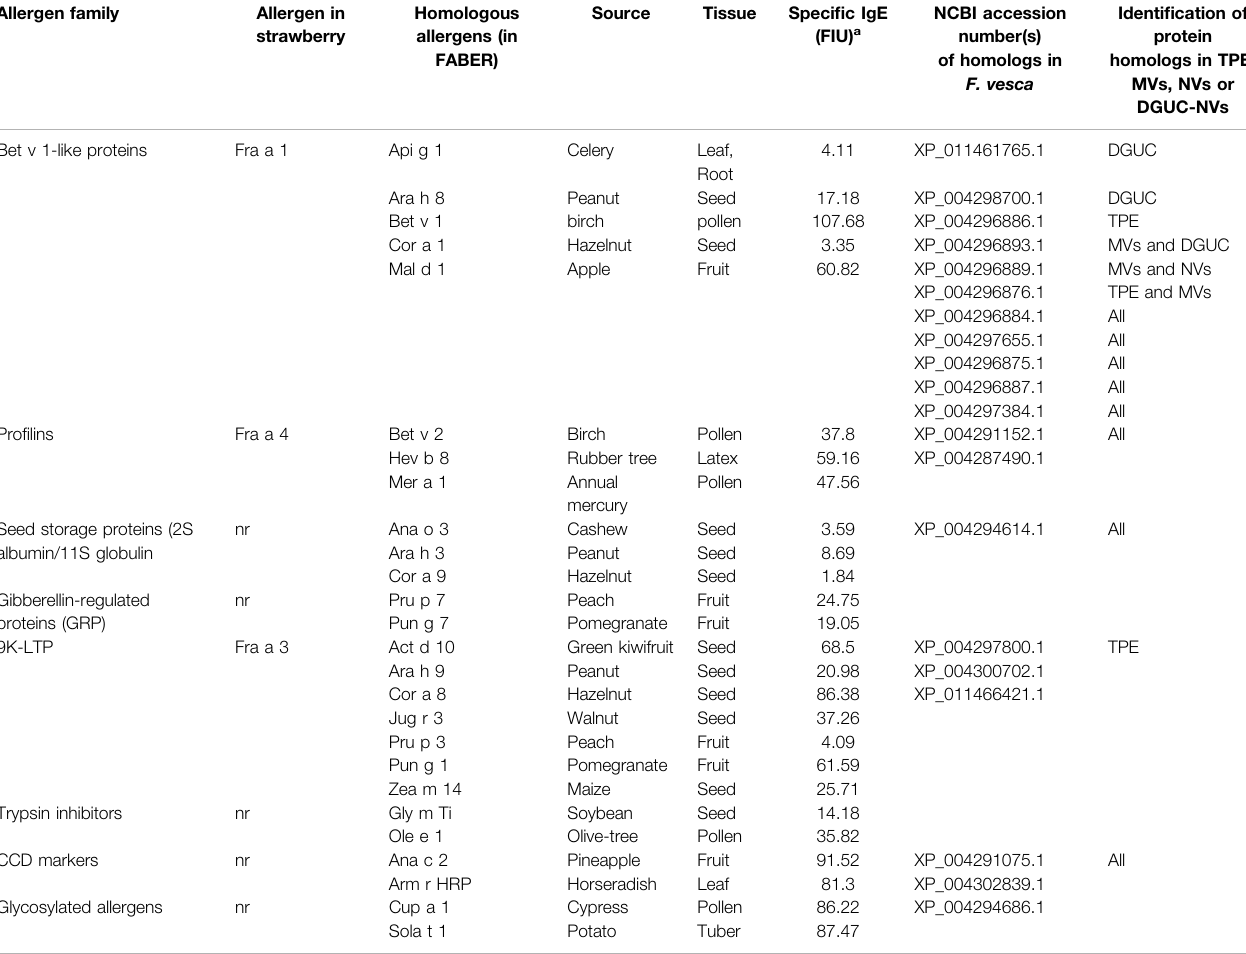
TABLE 2 | Details of plant allergens analyzed for competition in the IgE binding with the proteins contained in the vesicles samples. Allergen